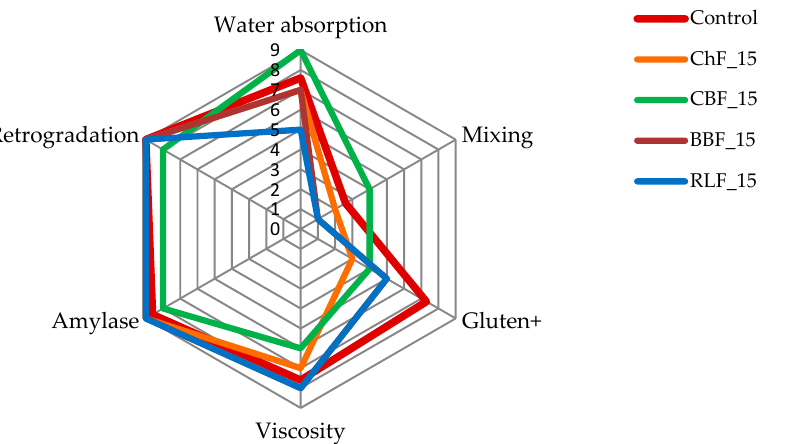
Figure 5. Mixolab Profiler-complete characterization (protein network, starch and enzyme activity) of control flour and flour with legume addition of 15% by fundamental criteria: water absorption index, mixing index, gluten+ index, viscosity index, amylase index and retrogradation index.